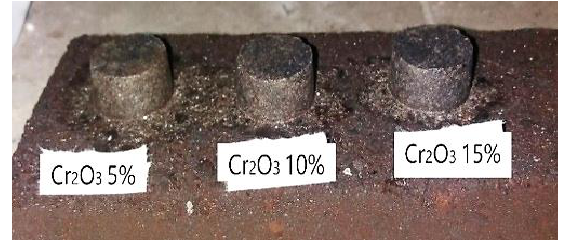
Figure 7. Peridotite sample E6382 with the MgO addition after calcination. Figure 8. Peridotite E6382 with the Cr 2 O 3 addition after calcination.